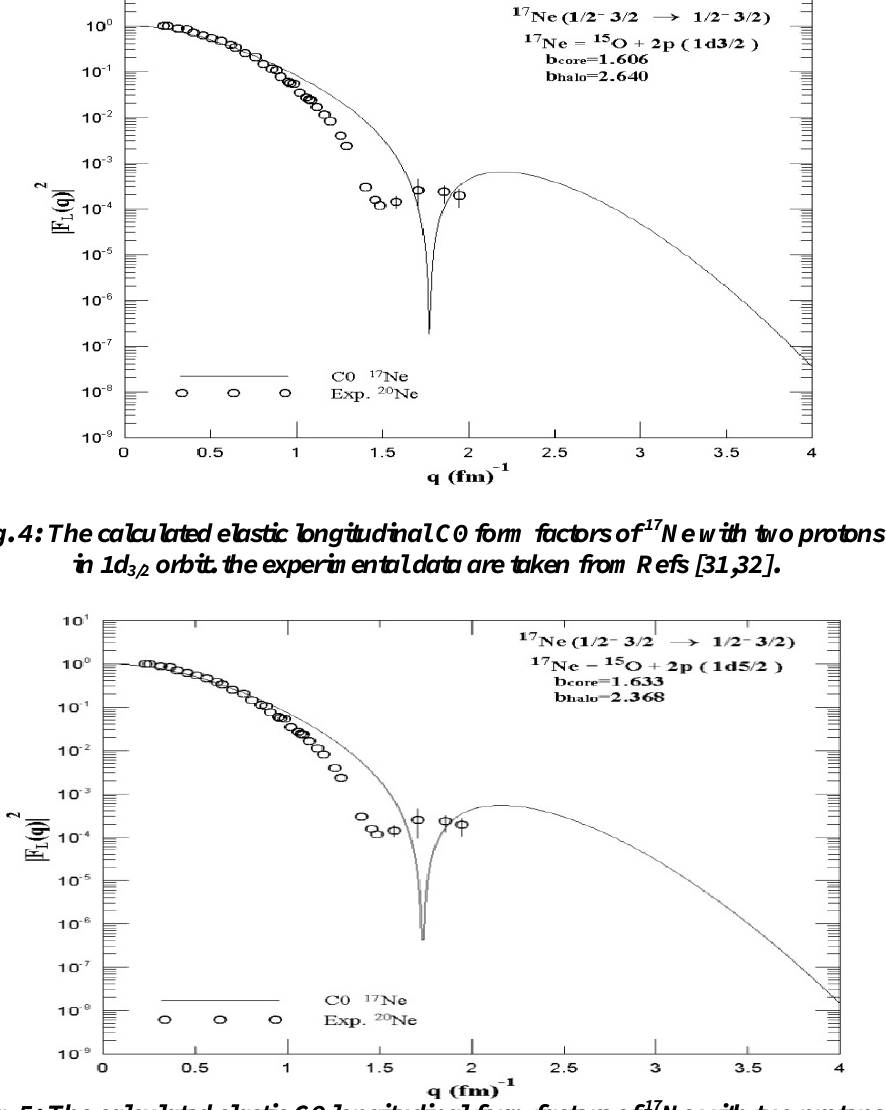
Fig. 5: The calculated elastic C0 longitudinal form factors of 17 Ne with two protons orbit. the experimental data are taken from Refs in 1d 5/2